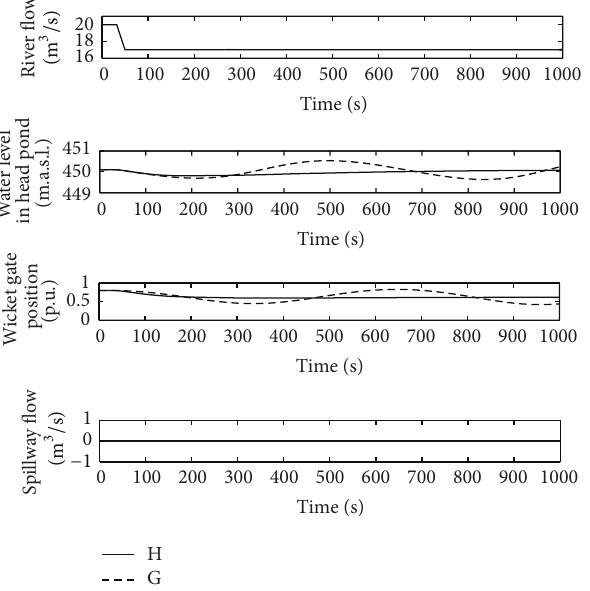
Figure 15: River flow, wicket gates position, water level in the head pond, and spillway flow, points G and H in normal operation.